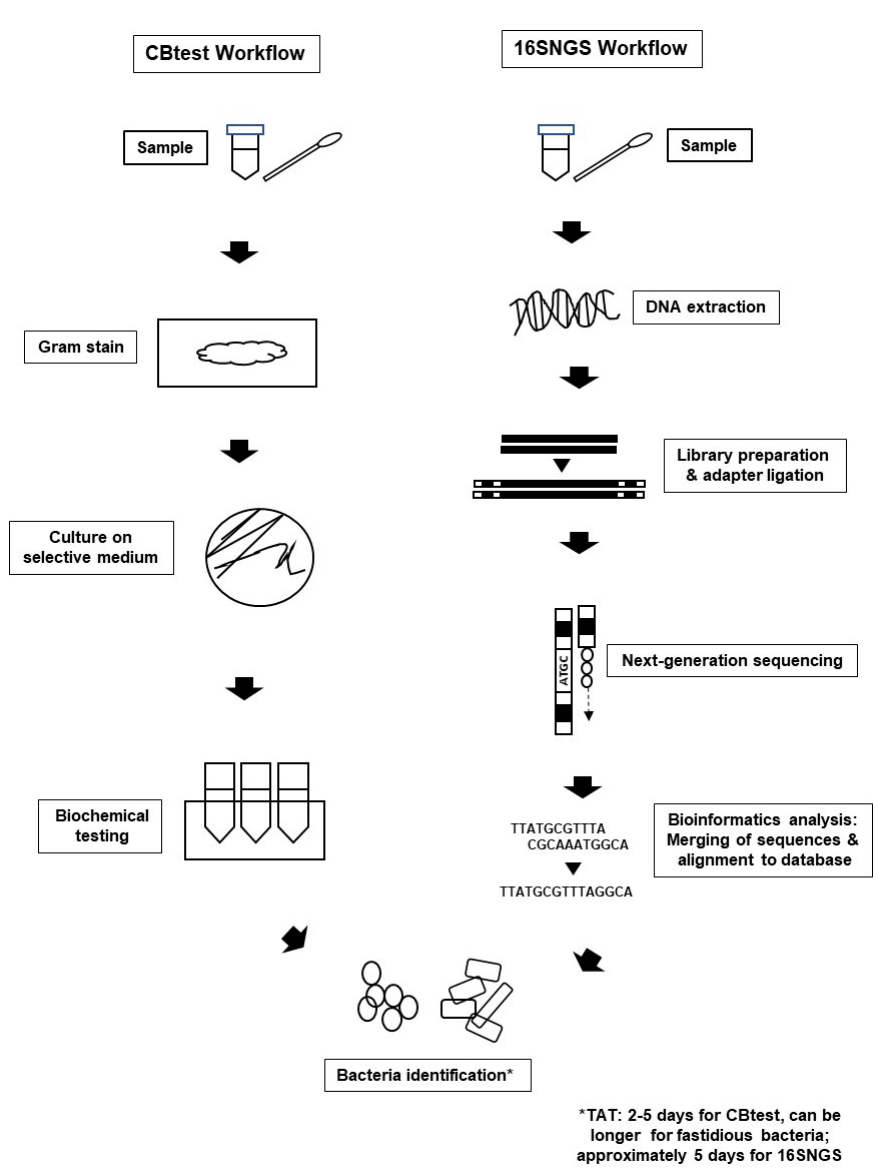
Figure 1. Bacterial identification workflow via CBtest is different from that of 16SNGS. For CBtest, samples are subjected to gram staining and culture on selective medium. Subsequent biochemical testing will reveal the identity of the bacterial pathogen. On the other hand, DNA extraction from samples is carried out in the first step of 16SNGS workflow. After library preparation, NGS of the 16S rRNA fragments will then be done, followed by bioinformatics analysis to identify the infecting bacteria. TAT of the identification process is workflow-dependent. CBtest, culture and biochemical testing. 16SNGS, 16S rRNA NGS. TAT, turn-around time.